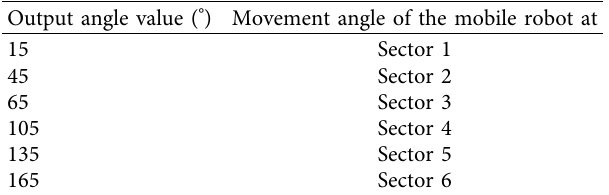
Table 6: Sample output values to the servo motor used in ANN to move the mobile robot by correction angle referring to the defined sectors in Table 1.